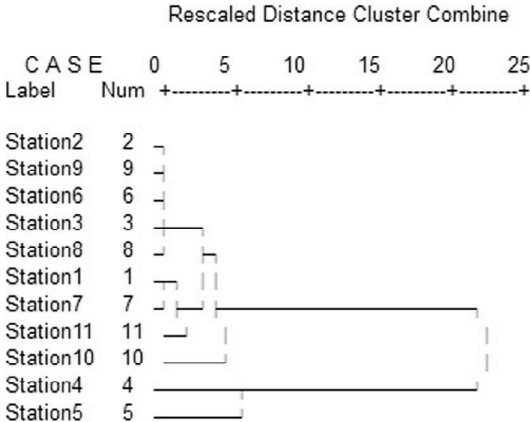
Figure 2. Dendrogram of the Ward method.